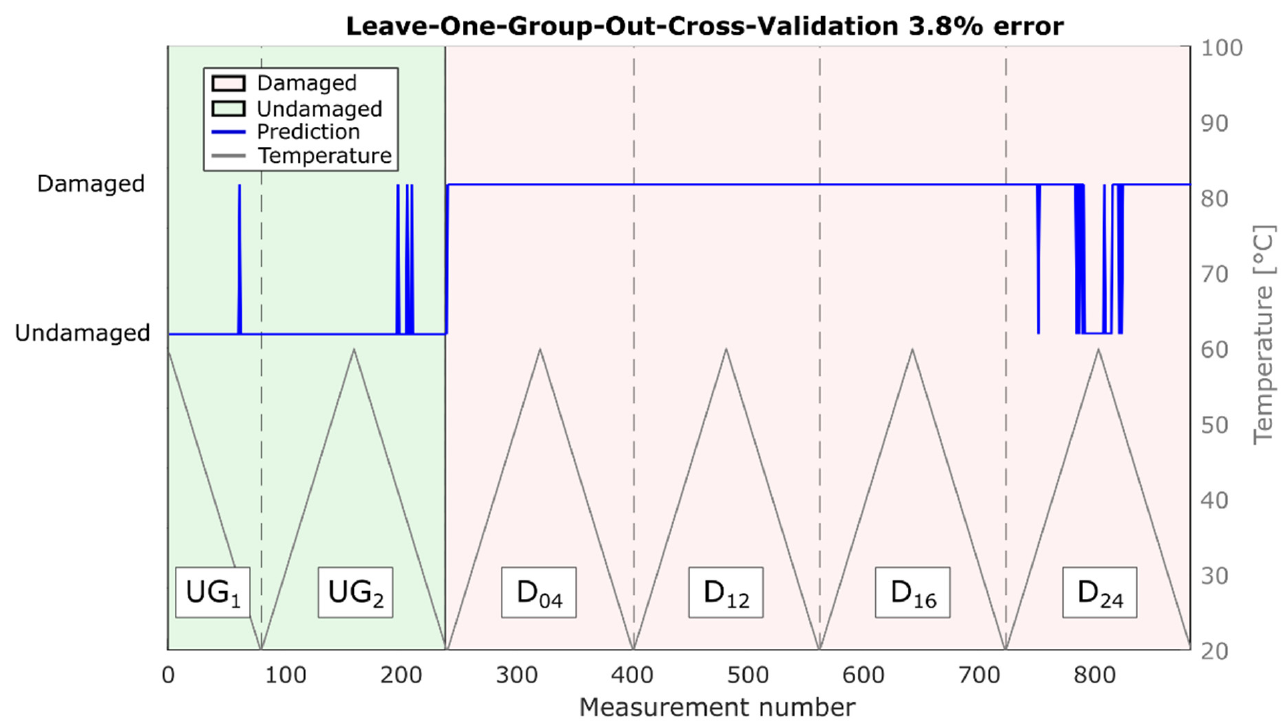
Figure 6. Damage classification results of the leave-one-class-out cross-validation. The plot is divided into six sections by dotted lines. Each section represents a heat cycle with one specific damage condition (undamaged and damaged D 04 , D 12 , D 16 , D 24 ).